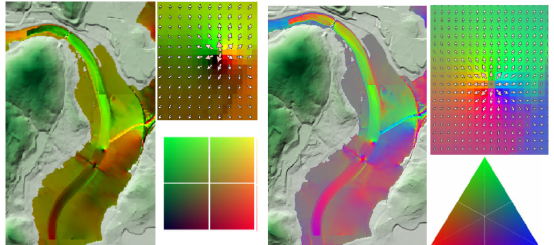
Figure 3. Stylization for current direction representation, based on a color wheel: direction is linked to hue color. (1) Left: Color gradient applied to the water speed decomposed into 2 axis (north-south and east-west), giving the direction of the current; (2) Right: Color gradient applied to the water speed decomposed into 3 axis (north, south-east,